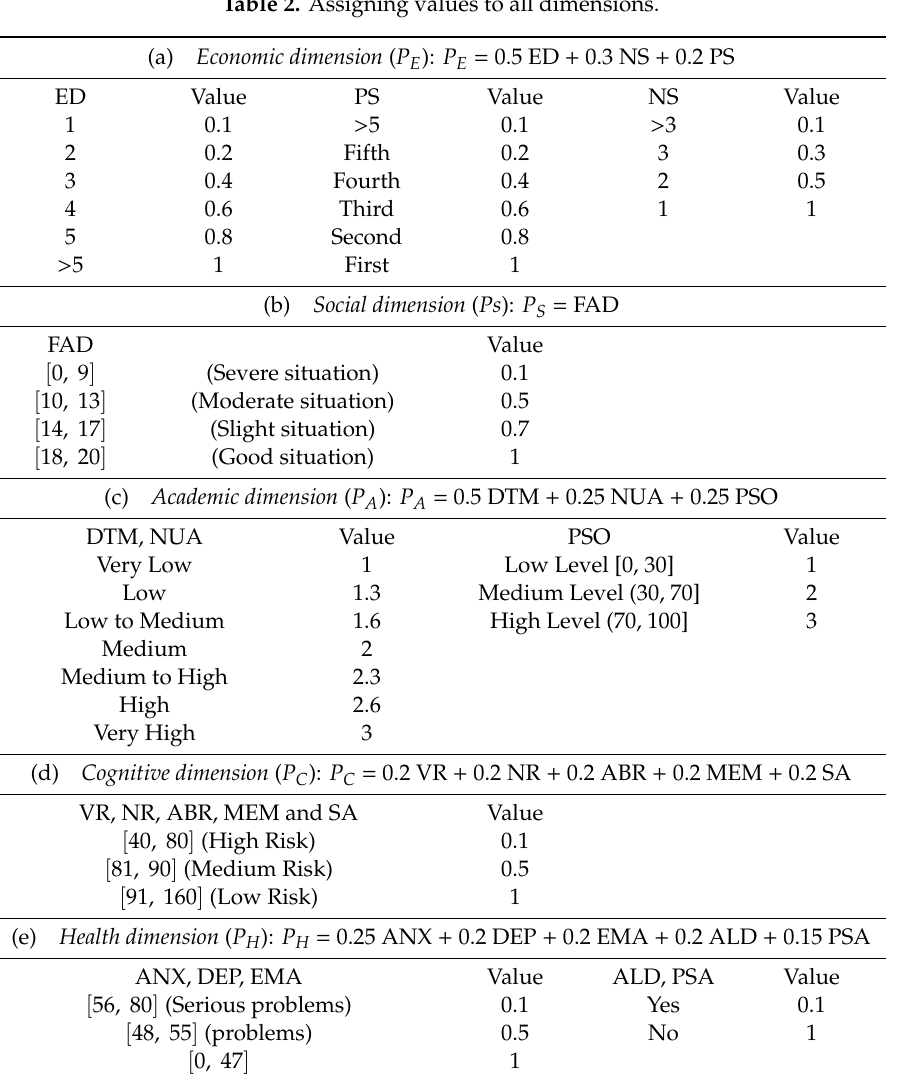
Table 2. Assigning values to all